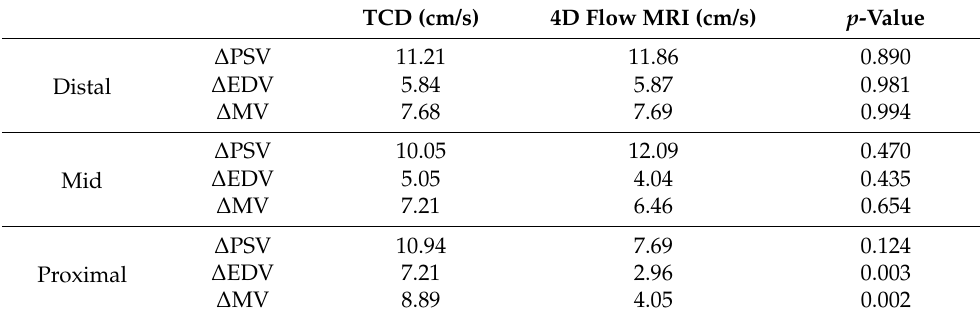
Table 2. Absolute values of mean difference between right and left M1 velocities. TCD (cm/s) 4D Flow MRI (cm/s) p -Value ∆ Distal